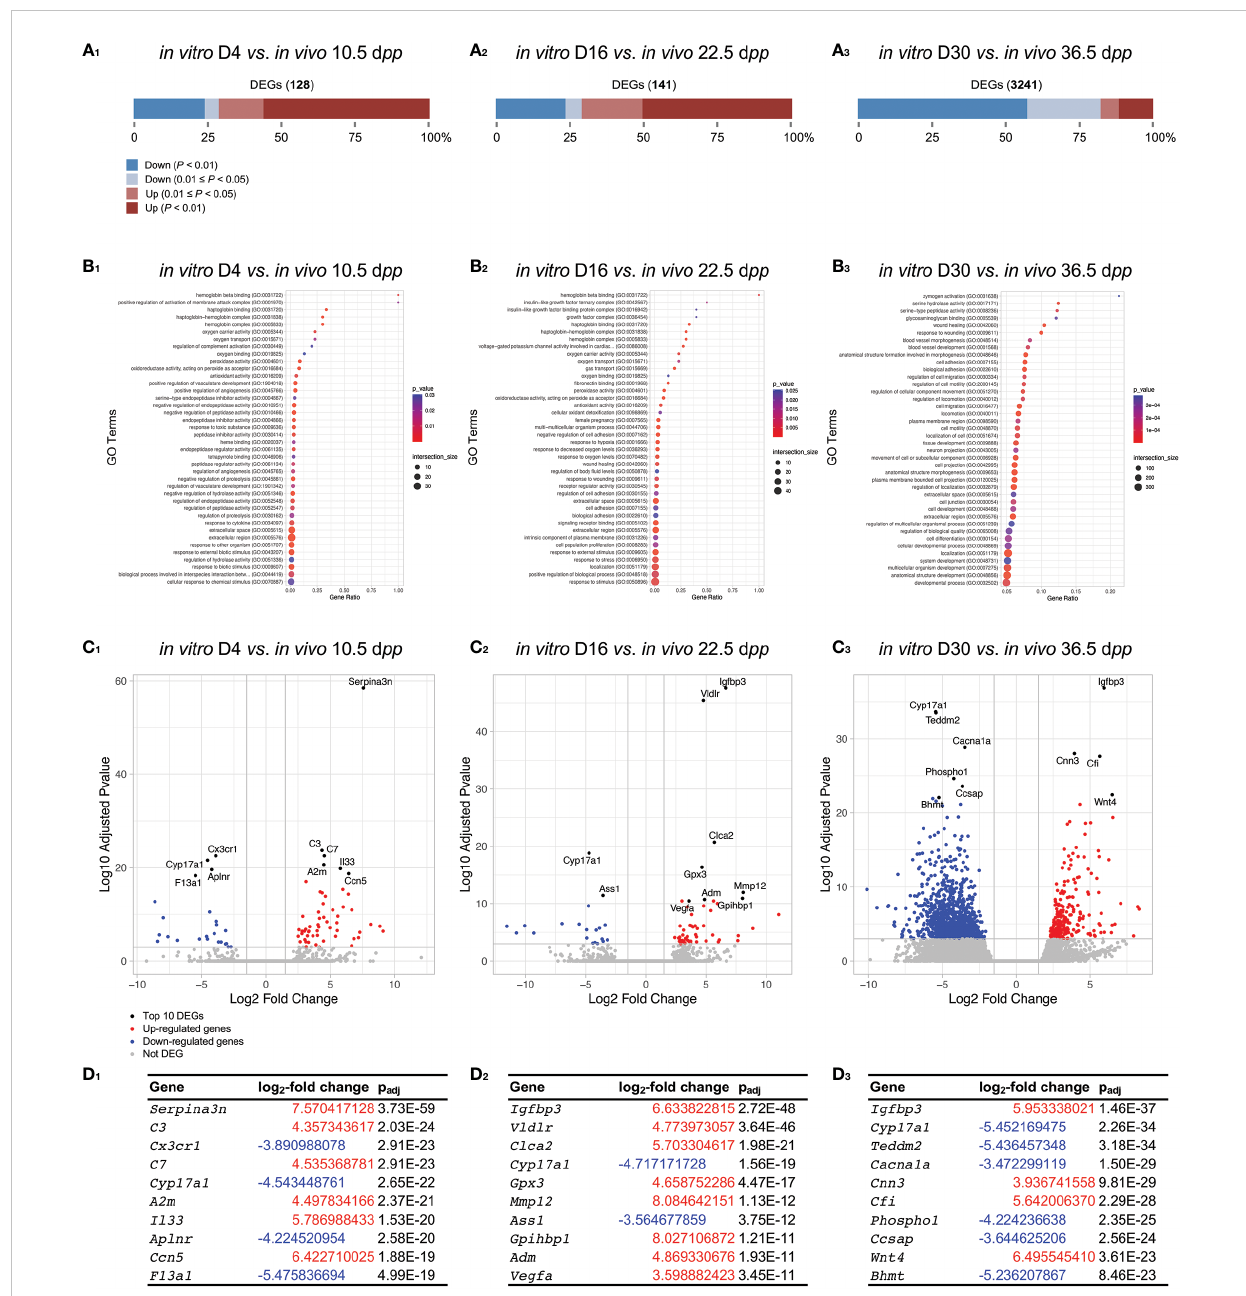
FIGURE 7 Gene-level differential expression analysis between in vitro and in vivo age-matched testicular samples. (A) The proportion of signi fi cantly DEGs are shown between in vitro and in vivo testicular tissue samples for D4 vs . 10.5 d pp (A 1 ) , D16 vs . 22.5 d pp (A 2 ) , and D30 vs . 36.5 d pp (A 3 ) . The number of DEGs for each comparison is available in order to have an appreciation of the difference in gene expression between the two conditions compared. (B 1-3 ) Corresponding GO enrichment dot plot. The 40 GO processes with the largest gene ratios are plotted in order of gene ratio. The size of the dots represent the number of genes in the signi fi cant DEGs associated with the GO Terms and the color of the dots represent the p adj values. (C 1-3 ) Volcano plots compare the amount of gene expression change to the signi fi cance of that change (here plotted as the log 10 transformation of the multiple test p adj value), with each point representing a single gene. The top 10 gene candidates are highlighted in black and by text labeling. The two marginal plots showing the distributions of the log 2 -fold changes and negative log10 p adj values are used to show cutoff choices and trade-offs. (D 1-3 ) Top ten DEGs with corresponding log 2 -fold change and p adj value. DEGs, differentially expressed genes; d pp , days postpartum